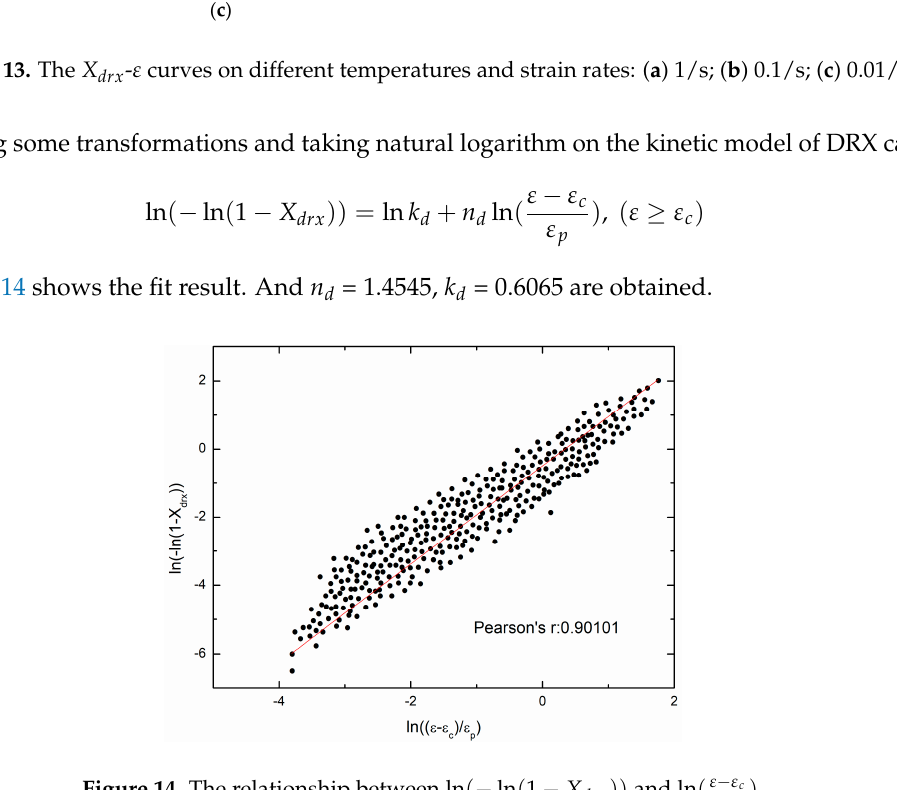
Figure 14. The relationship between ln( ln(1 )) drx X − − and ln( ) c